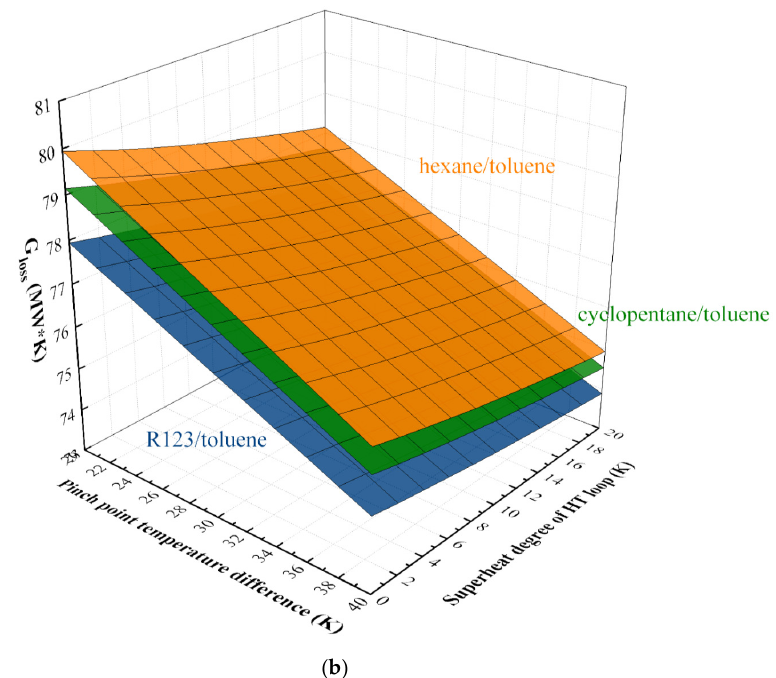
Figure 7. E ff ects of superheating degree and pinch point temperature di ff erence of HT loop: ( a ) Entropy Figure 7. Effects of superheating degree and pinch point temperature difference of HT loop: ( a ) generation rate; ( b ) entransy loss Entropy generation rate; ( b ) entransy loss rate.